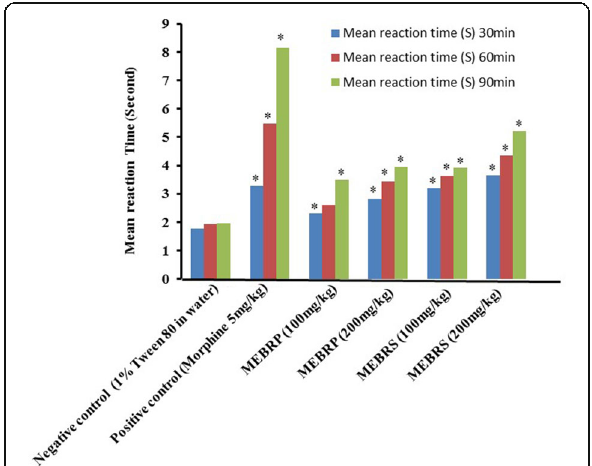
Fig. 3 Analgesic effects of the methanol extract of the Baccaurea ramiflora pulp and seed on tail immersion test in mice. Values are means ± SEM of five mice ( n = 5); * p < 0.05, Dunnett ’ s test compared to control. Control group received normal saline; standard groups received morphine 5 mg/kg body weight (i.p.); test animals were treated with 100 and 200 mg/kg (p.o.) body weight of the MEBRP and MEBRS,